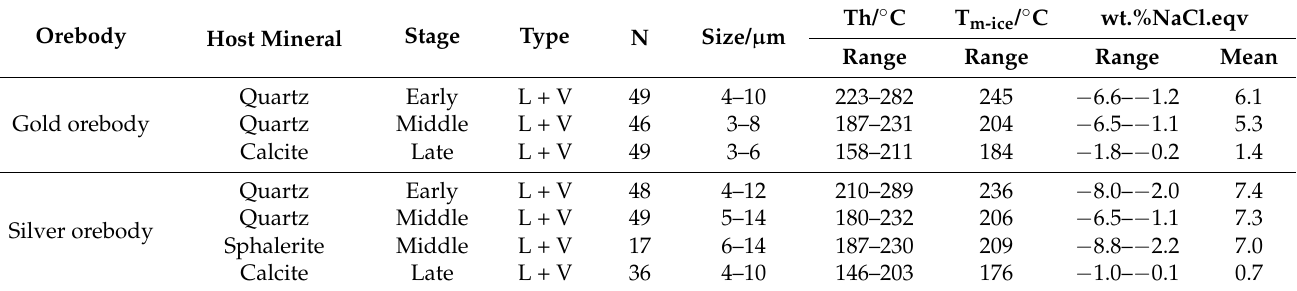
Table 1. Microthermometric data of FIs in the Changkeng–Fuwan Au-Ag deposit.